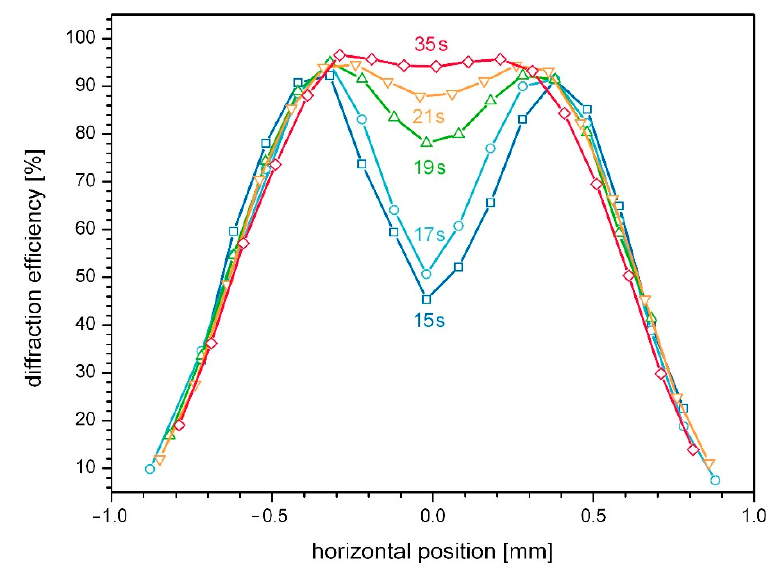
Figure 5. Interplay of exposure duration and pre-exposure on the intensity response. Gratings are subsequently created from short to long exposure duration, i.e., in the sequence 15 s (dark blue squares), 17 s (blue circles), 19 s (green triangles up), 21 s (orange triangles down) and 35 s (red diamonds).